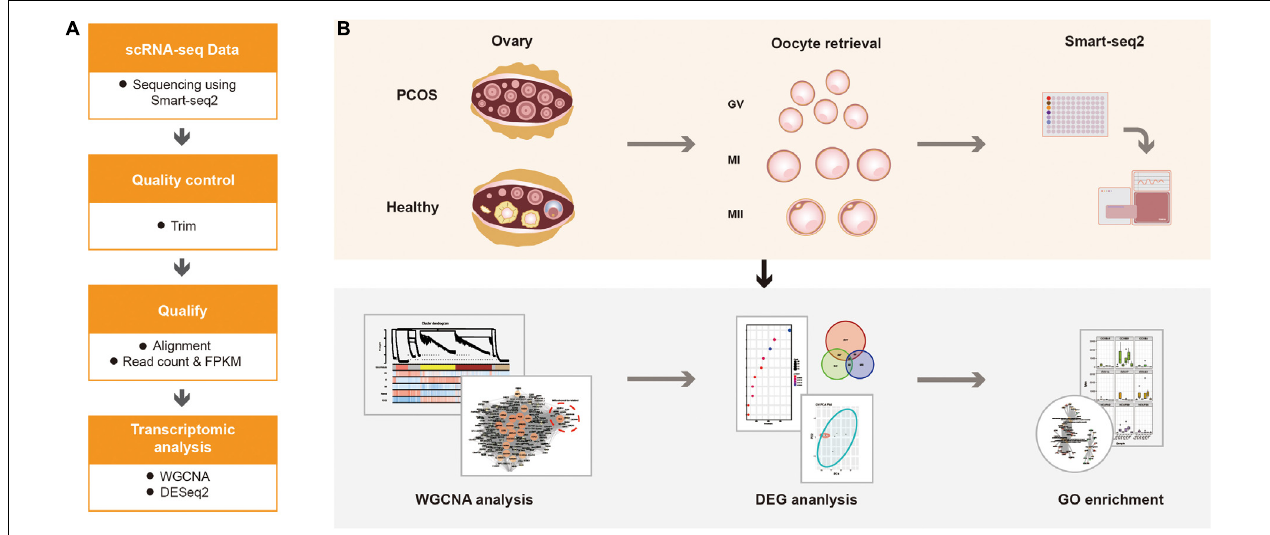
FIGURE 1 | The schematics of the study design. (A) The progress of data alignment. After acquiring the raw data of Smart-seq2, the adaptor contaminants and low-quality reads were trimmed. Then, number of mapped read in the BAM file of each sample were aligned to read count and FPKM. (B) The progress of the study. scRNA-seq data were obtained at different oocyte development stages (GV, MI, and MII) from healthy women and patients with PCOS, the processed data were used for WGCNA, differential gene expression analysis and GO enrichment analysis to detect the dynamic changes of transcriptome.